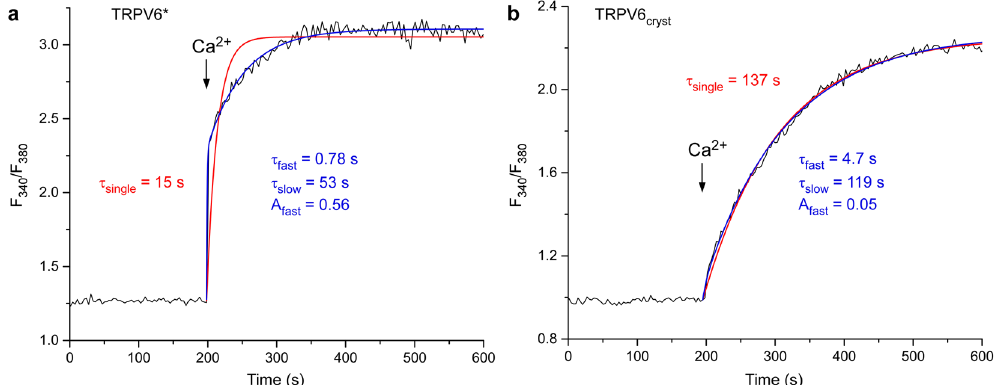
Figure 7. Different kinetics of ratiometric curves for TRPV6 * or TRPV6 cryst at physiological extracellular calcium concentration. ( a - b ), Representative ratiometric fluorescence measurements for HEK cells expressing TRPV6 * ( a ) or TRPV6 cryst ( b ). Arrows indicate the time at which 2 mM Ca 2 + was added. The curves were fitted with one (red) or two (blue) exponentials. Note, TRPV6 * kinetics was well described by the double but not the single exponential. Over three measurements, the time constants of the single exponential fit ( τ single ) were 14.5 ± 2.7 s for TRPV6 * and 110 ± 16 s for TRPV6 cryst , τ fast = 2.2 ± 1.0 s, τ slow = 54 ± 11 s and A fast = 0.57 ± 0.01 for TRPV6 * and τ fast = 5.4 ± 2.8 s, τ slow = 135 ± 23 s and A fast = 0.10 ± 0.03 for TRPV6 cryst . At n = 3, the values of τ < 0.05). single and A fast for TRPV6 * and TRPV6 cryst were statistically different (t-test, P